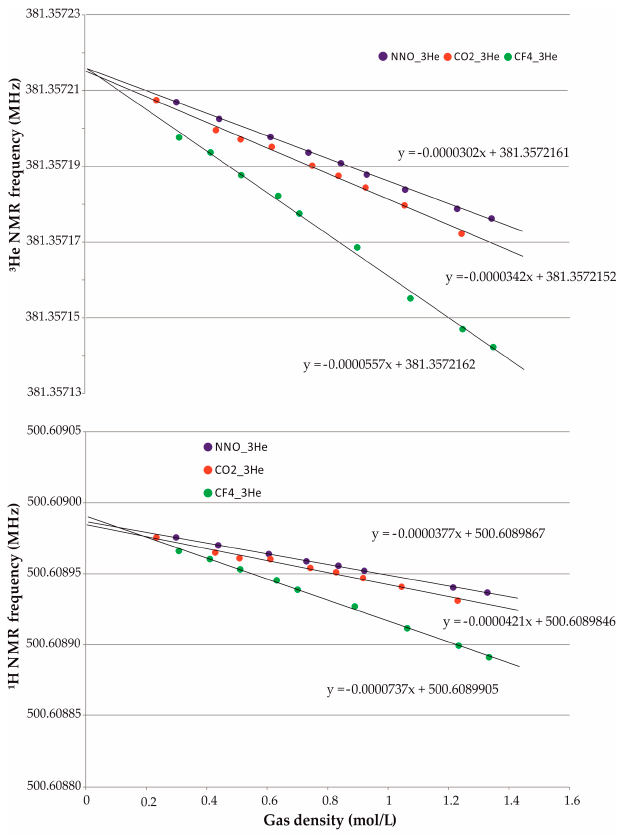
Figure 1. 1 H and 3 He NMR frequencies recorded in 3 He / H 2 mixture immersed in bu ff er gases: CF 4 , CO 2 , and N 2